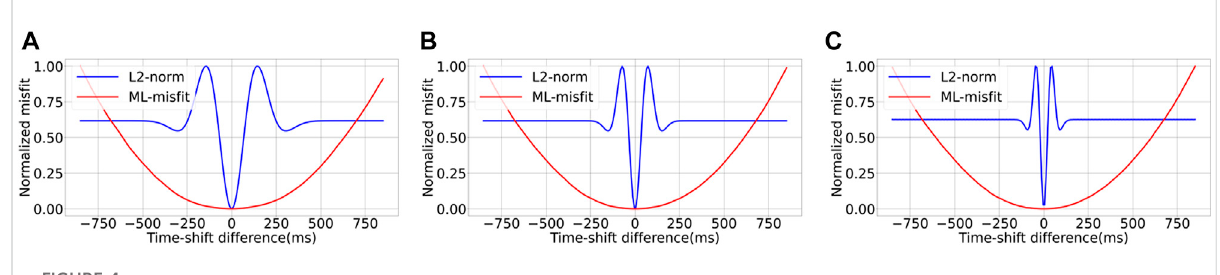
FIGURE 4 Mis fi t curves for the L2 norm and the ML-mis fi t with respect to time shifts for data with main frequency (A) 3 Hz, (B) 6 Hz, and (C) 10 Hz.